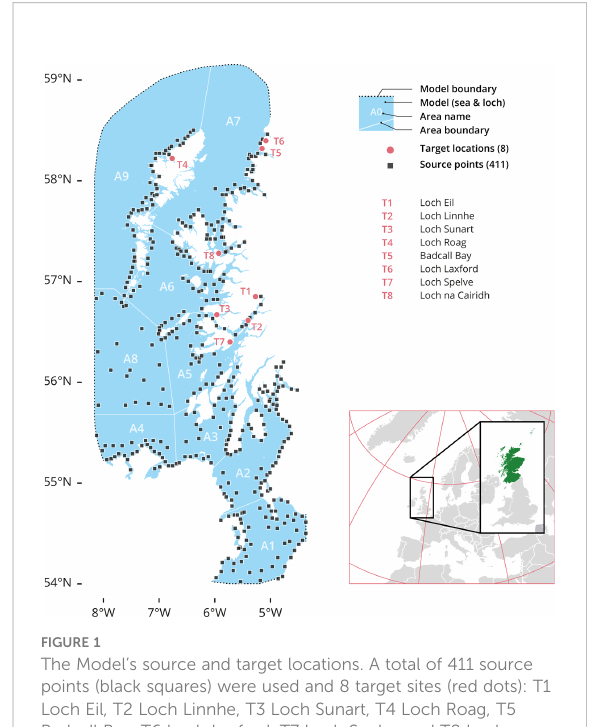
FIGURE 1 The Model ’ s source and target locations. A total of 411 source points (black squares) were used and 8 target sites (red dots): T1 Loch Eil, T2 Loch Linnhe, T3 Loch Sunart, T4 Loch Roag, T5 Badcall Bay, T6 Loch Laxford, T7 Loch Spelve and T8 Loch na Cairidh. The model also spliced the region in 9 geographical area divisions: A1. Northern Irish Sea and Solway Firth; A2. North Channel and Firth of Clyde; A3. Sound of Jura; A4. Malin Head or Northern coast of Ireland; A5. Firth of Lorne (and southern part of Inner Hebrides Sea); A6. South Minch and Small Isles; A7. North Minch; A8. Atlantic and South Hebrides; and A9. West Outer